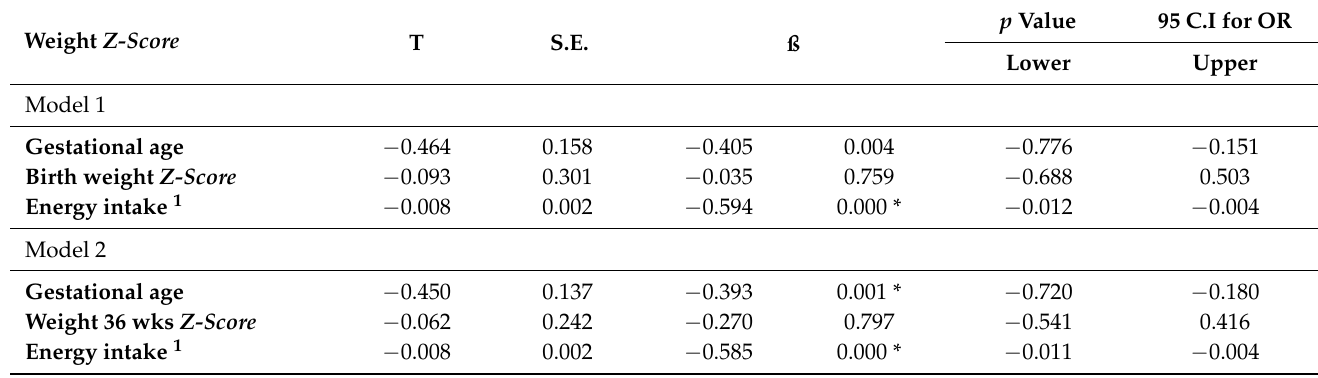
Table 7. Linear regression analysis of covariates on growth at 12